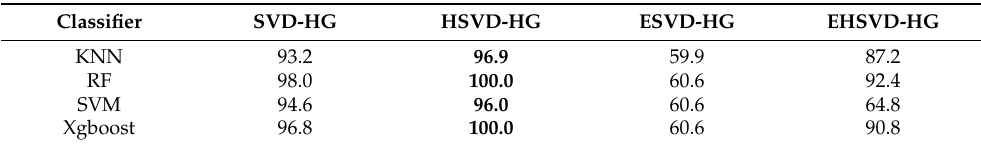
Table 6. Case Study-II: Classifiers Performance when Training and Testing with Different Oil Tem- peratures (training at 23 ◦ C and testing at 70 ◦ C).